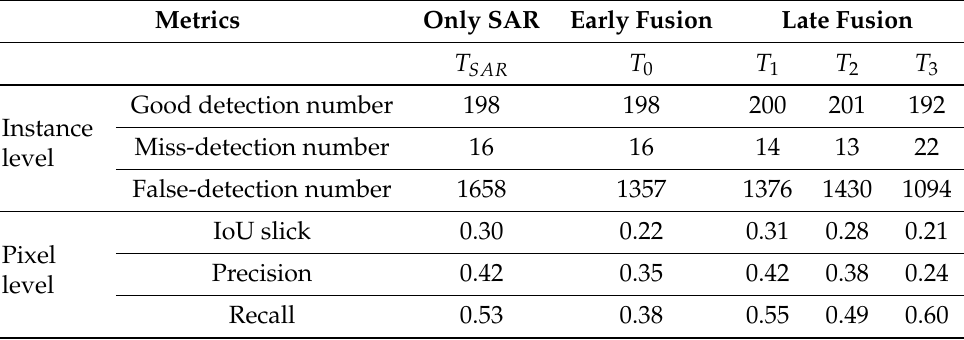
Table 7. Comparison of the FC-DenseNet results on a test set of 214 slicks using only SAR data with different data fusion